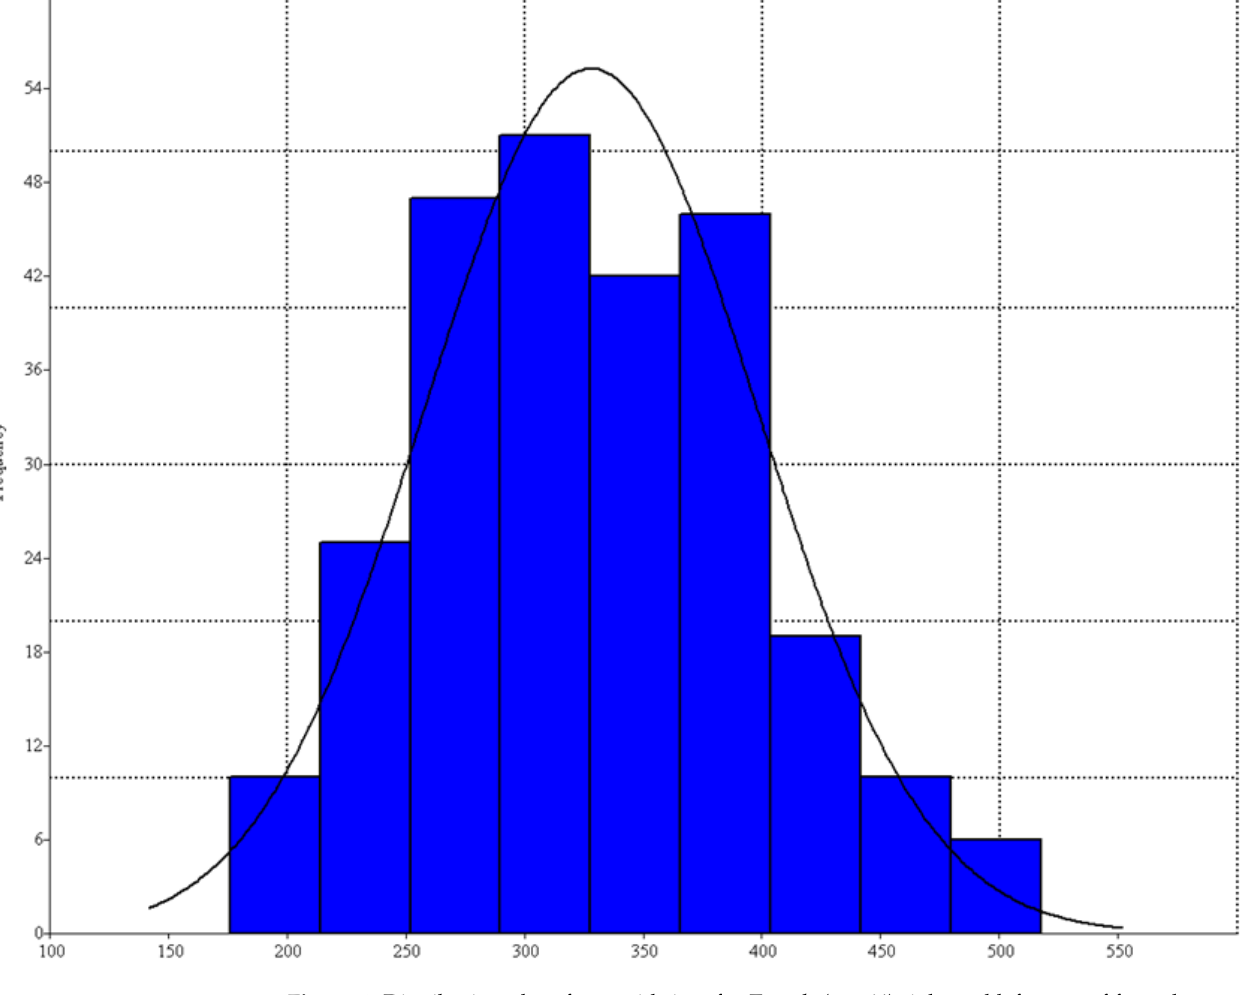
Figure 4. Distribution plot of centroid sizes for Testudo ( n = 64) right and left parts of frontal carapace. The line shows the graph with a fitted normal distribution ( p = 0.141). X-axis refers to centroid sizes. Finally, males presented a higher degree of asymmetry than females ( p = 0.0282; p -